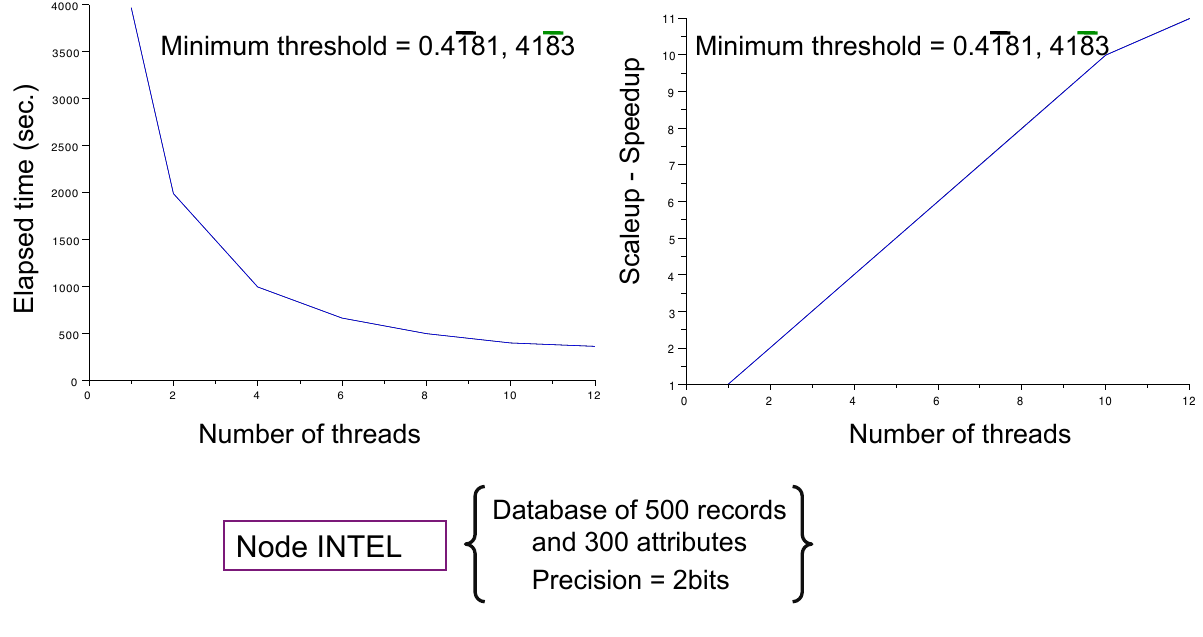
Figure 10. Execution time and Speedup related to the number of threads on Intel nodes for synthetic database of 300 attributes at precision 2 bits with minimum threshold values 0.17 and 0.18.